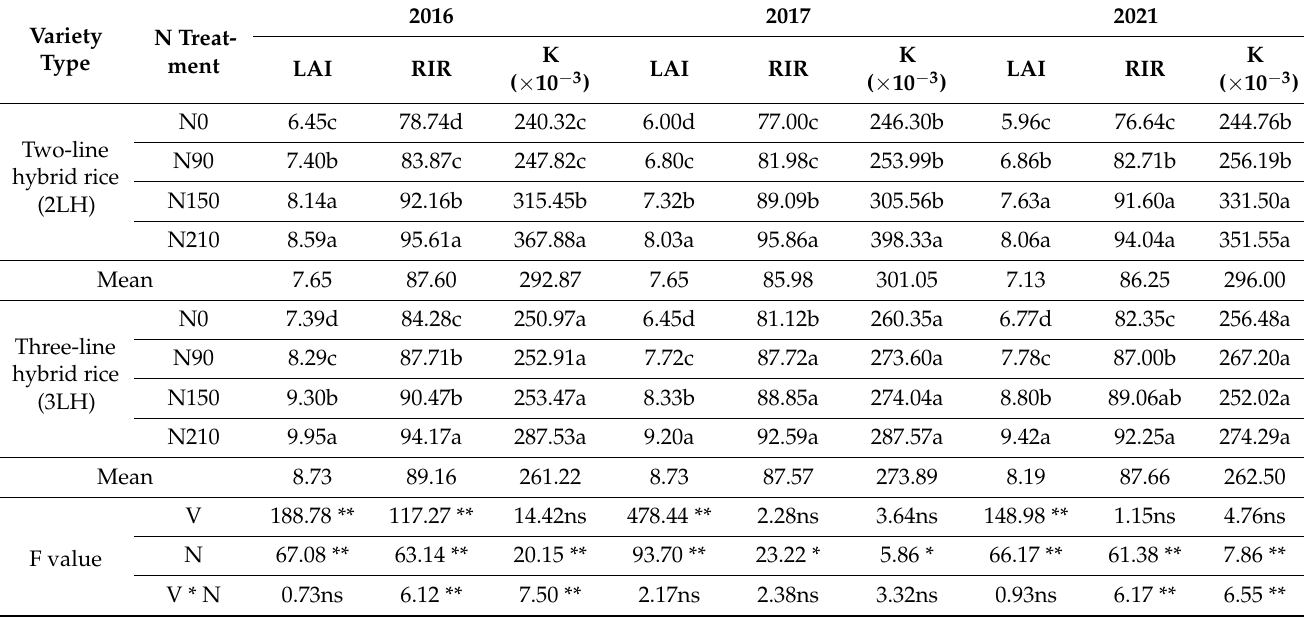
Table 5. Effects of nitrogen rates on LAI, RIR, and K value of the whole plant at heading stage in two rice types.